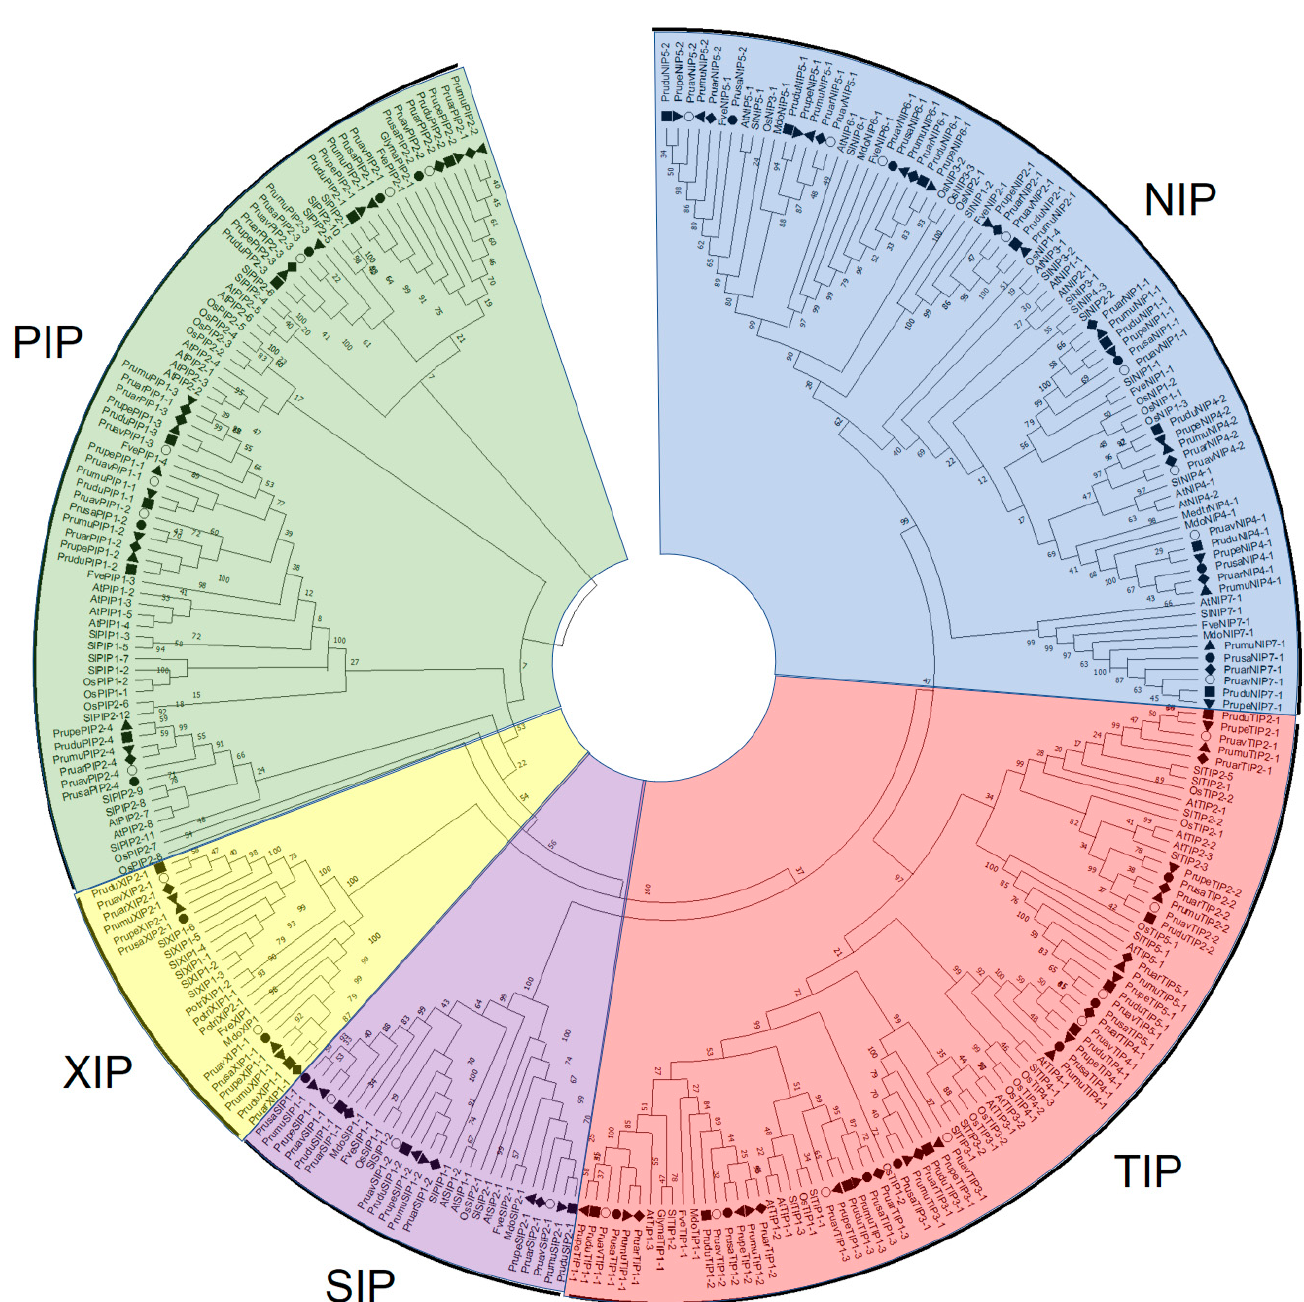
Figure 2. Phylogenetic tree of identified aquaporins in P. avium and other plant species. Open circles represent sequences from P. avium . Black dots represent sequences from P. salicina . Black squares represent P. dulcis sequences. Black rhombi represent sequences from P. armeniaca . Black triangles represent sequences from P. mume . Upside down black triangles represent sequences from P. persica.